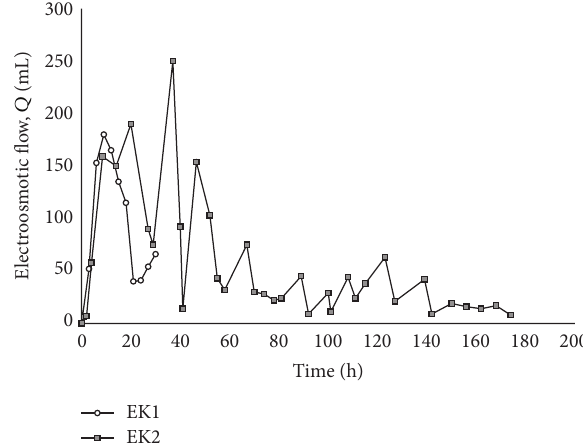
Figure 5: Electroosmotic flow ( 𝑄 ) as a function of treatment time (EK1,